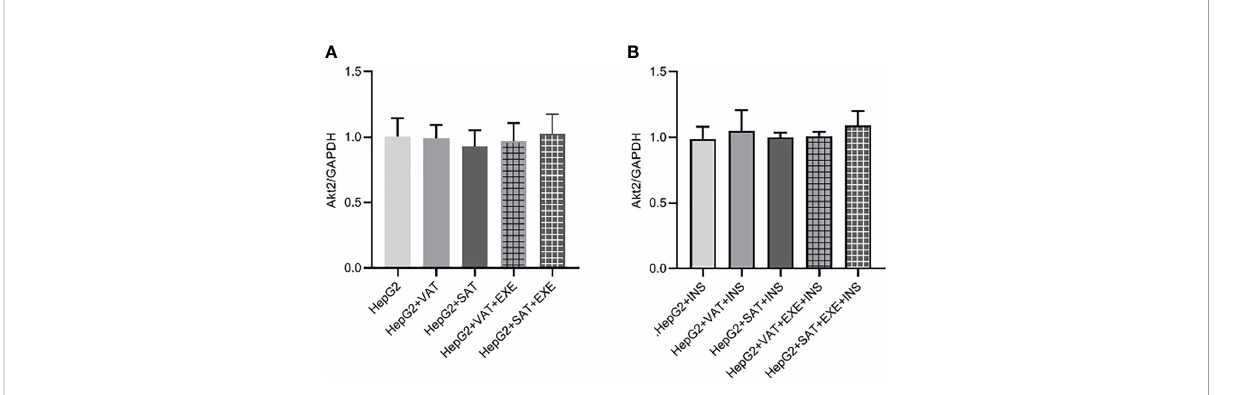
FIGURE 8 The in fl uence of exenatide on the expression of Akt2 protein in hepatocytes conducted by different regional adipose tissue. (A) Expression of Akt2 protein in HepG2 cells of each group. Data are means ± SEM, n = 3/group. (B) Expression of Akt2 protein in HepG2 cells of each group under the action of insulin. Data are means ± SEM, n = 3/group.